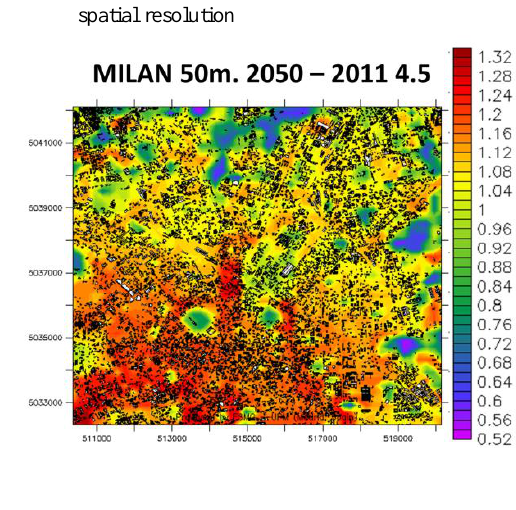
Figure 1. Yearly average of spatial distribution of the differences (%) mortality for natural causes due to air pollution and temperature for 2100 respect to 2011 following RCP 4.5 (top) and RCP 8.5 (bottom) scenarios with WRF-Chem-MICROSYS over Kensington-Chelsea (London) with 50